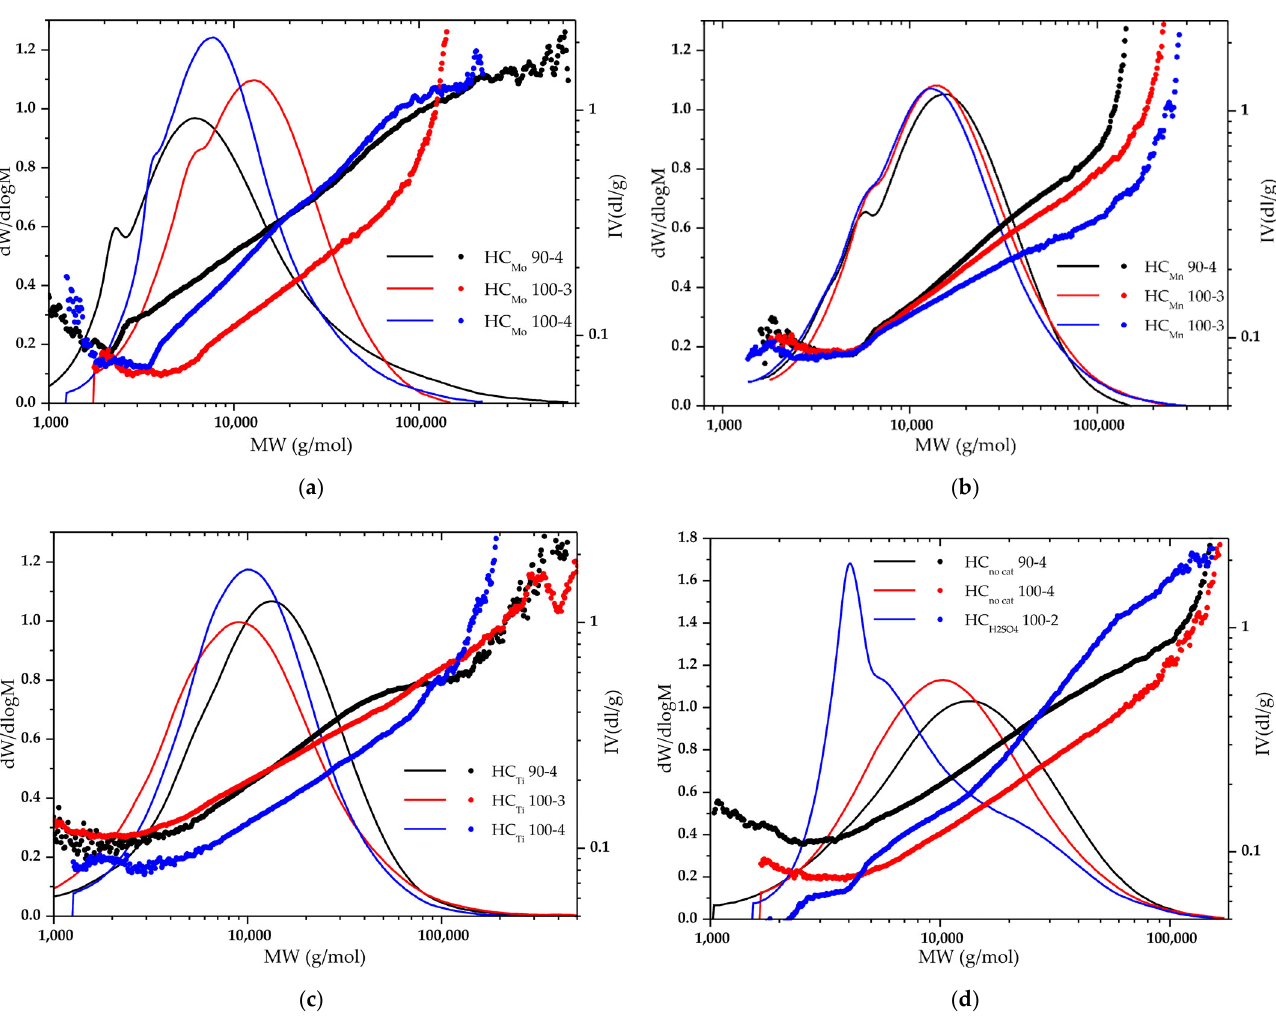
Figure 2. Molecular weight distribution curves and Mark ‒ Houwink ‒ Sakurada plots for the hemicelluloses obtained by oxidative delignification of spruce wood with the ( a ) (NH 4 ) 6 Mo 7 O 24 , ( b ) MnSO 4 , ( c ) TiO 2 , and ( d ) H 2 SO 4 catalysts and without them.